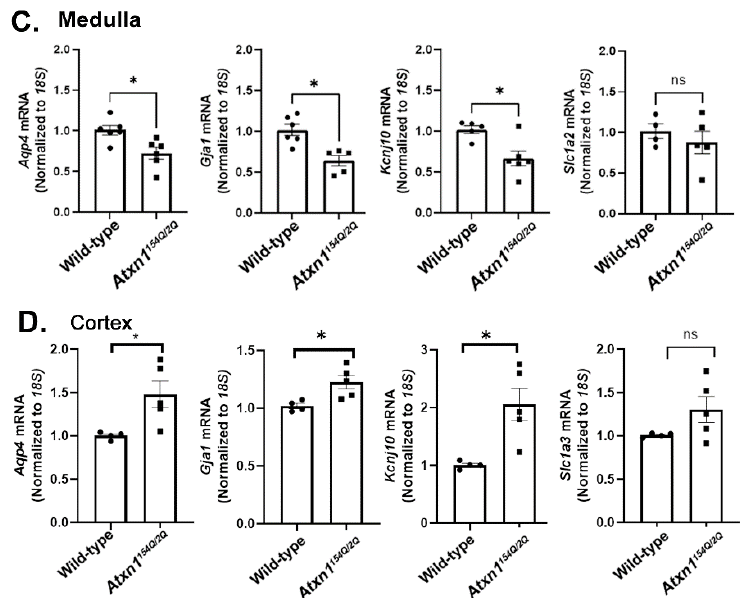
Figure 2. Spatial diversity of molecular changes in astrocytes during early SCA1. mRNA was extracted from the cerebellum ( A ), hippocampus ( B ), medulla ( C ), and cortex ( D ) of 12 weeks old Atxn1 154Q/2Q mice and wild-type littermate controls (N = 4–6) and RTqPCR was used to evaluate expression of astrocyte specific genes. Data are presented as mean ± SEM with average values for each mouse. N = 4–6 mice of each genotype (WT and Atxn1 154Q/2Q ) with individual mice represented by a dot in bar graphs. ns: not significant, * p < 0. 05 Students t -test.